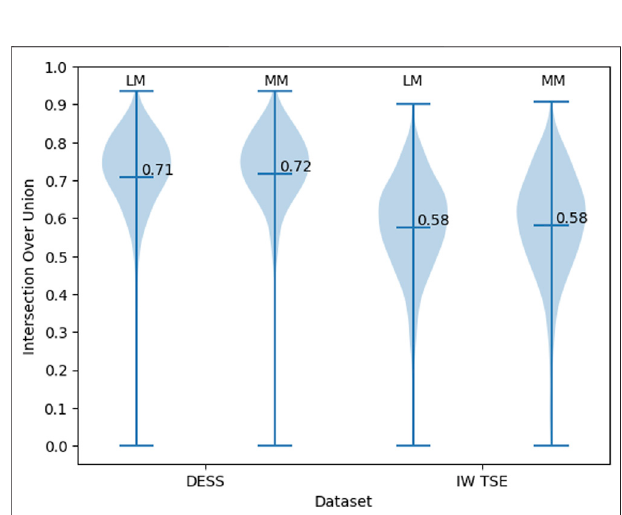
FIGURE 4 | ROC curves for detection of meniscal tears in IW TSE MRI data.